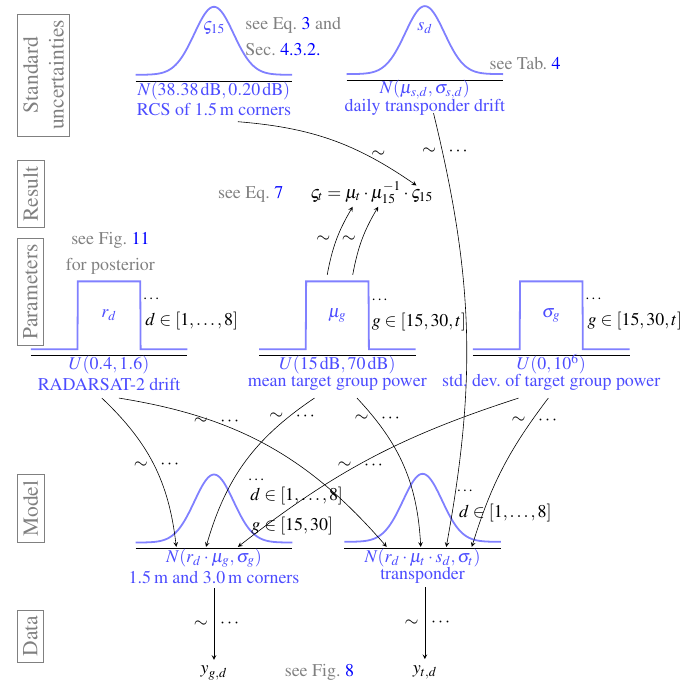
Figure 10. Diagram of the Bayesian model. The ellipsis symbol . . . indicates a family of probability distributions (per group g or overpass d ), whereas drawn from the respective distribution.